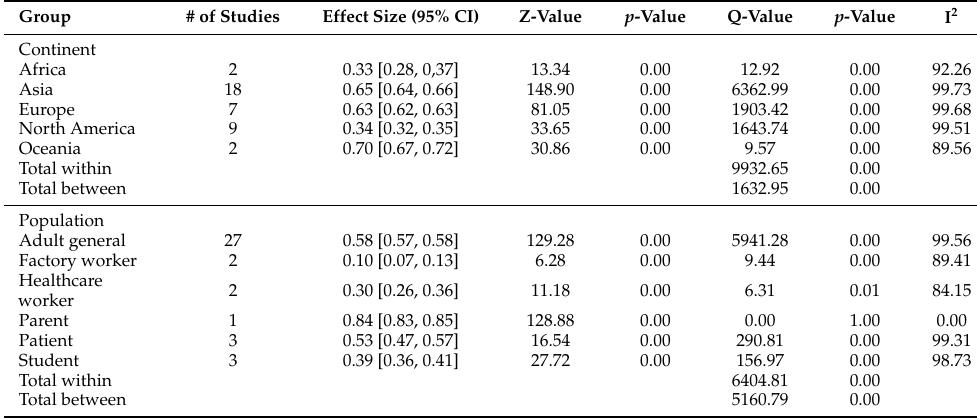
Table 3. The Meta-analysis Results of Subgroup Analyses (Attitude–Intention).